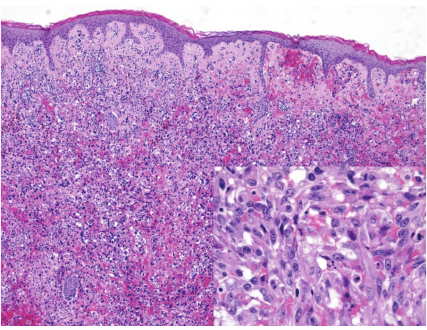
Figure2:Surgicalspecimendisplayingwell-differentiatedASwhich arose in AVL (H&E, × 10; inset , H&E, ×